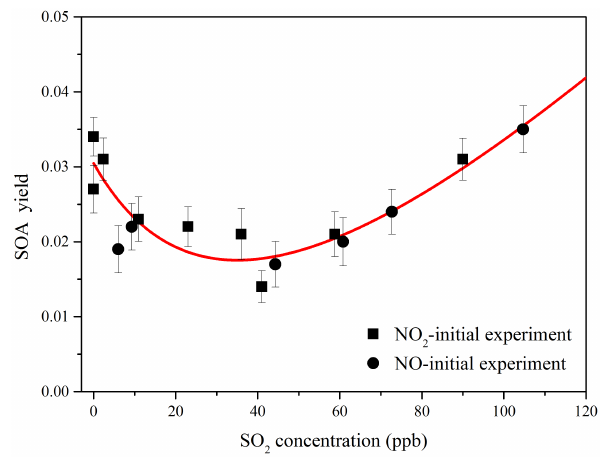
Figure 2. SOA yields of cyclohexene photooxidation in the pres- ence of NO x at different initial SO 2 concentrations. The solid line is the least-square fit of the data. The error bars were determined on the basis of propagation of uncertainties arising in the (cid:49) HC mea- surements, including GC calibration uncertainties propagation and the variance in the initial cyclohexene